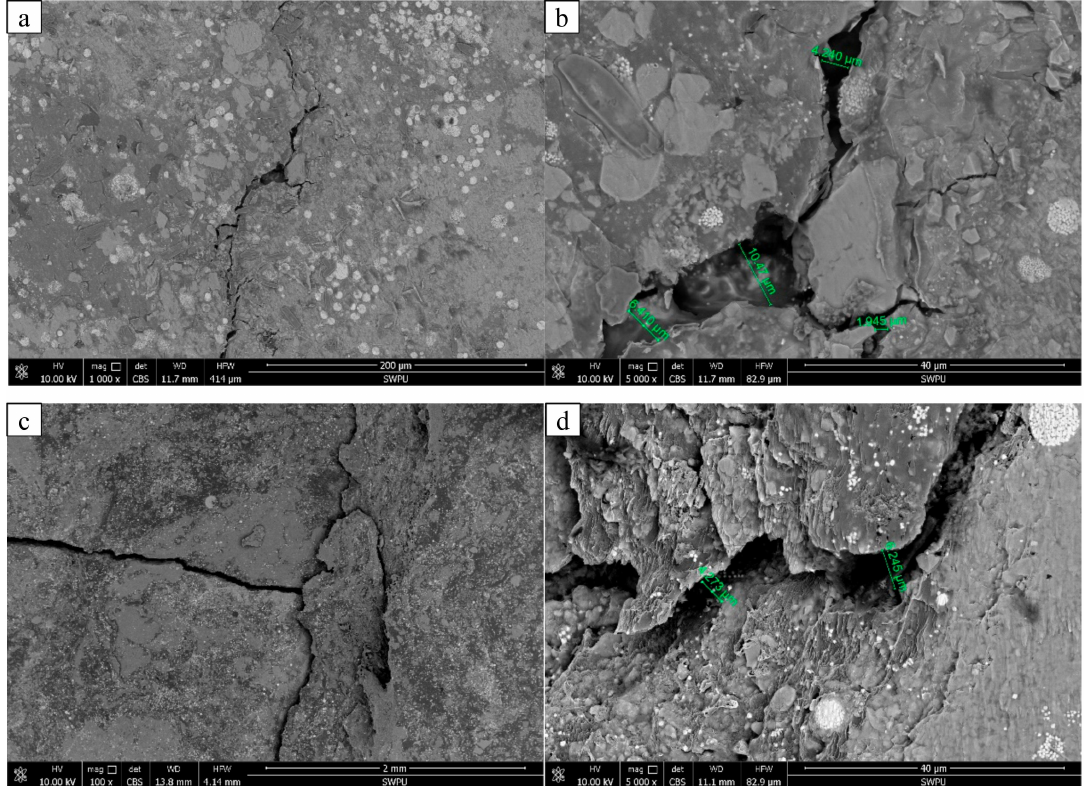
Figure 17. Scanning electron microscopy photographs after soaking in water; ( a ) and ( b ) water soaking results in lower cementation strength of minerals on rock surface and the shedding of mineral particles, resulting in cracks; ( c ) and ( d ) rock layers and expansion of cracks after water